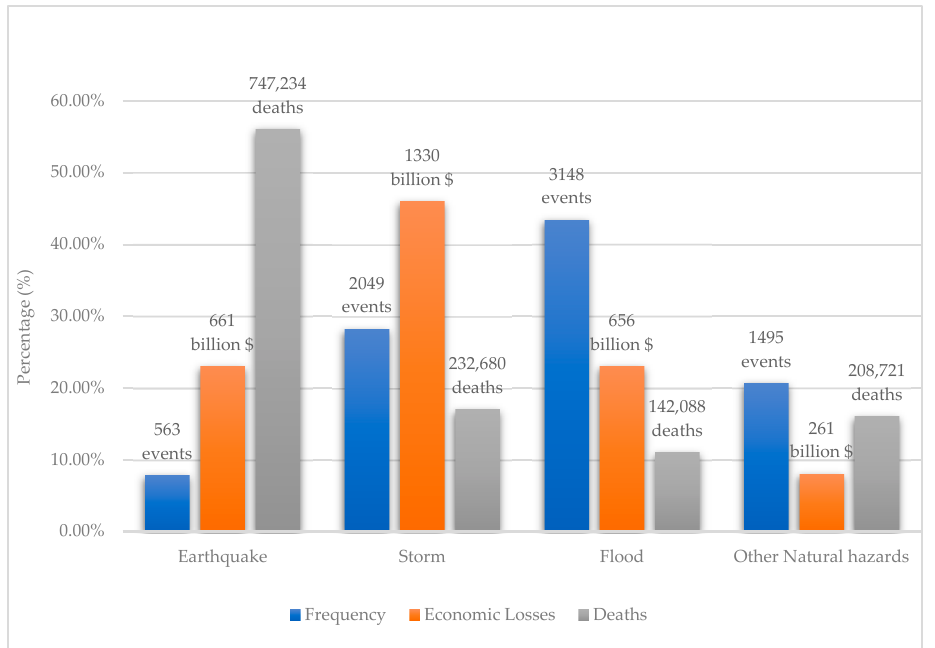
Figure 1. Frequencies of different natural hazards and their effects during 1998–2017 (based on CRED report, [1].